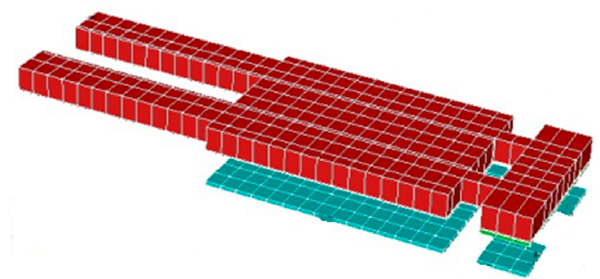
Figure 4. Meshing model.